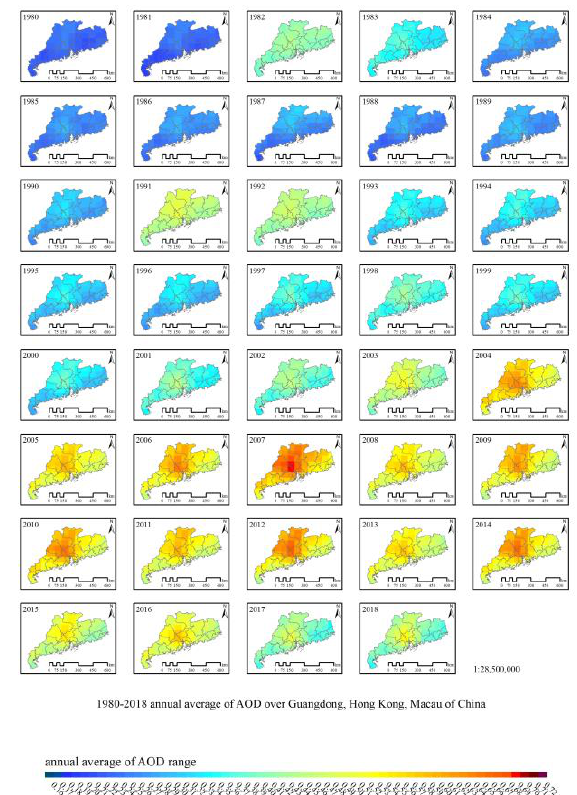
Figure 4. Spatial distribution patterns of yearly average AODs from 1980 to 2018. The map is produced by Kuang using ArcMap 10.5.